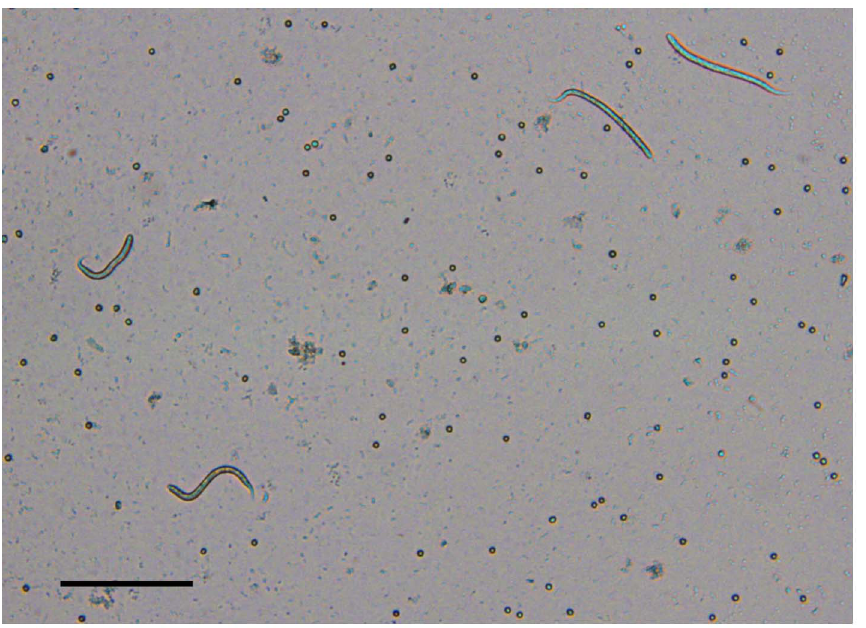
Figure 2. Onchocercalupi microfilariae in the skin sediment. Several Onchocerca lupi microfilariae collected from the right ear of dog 1 (second replicate) (Scale bar: 100 m m).